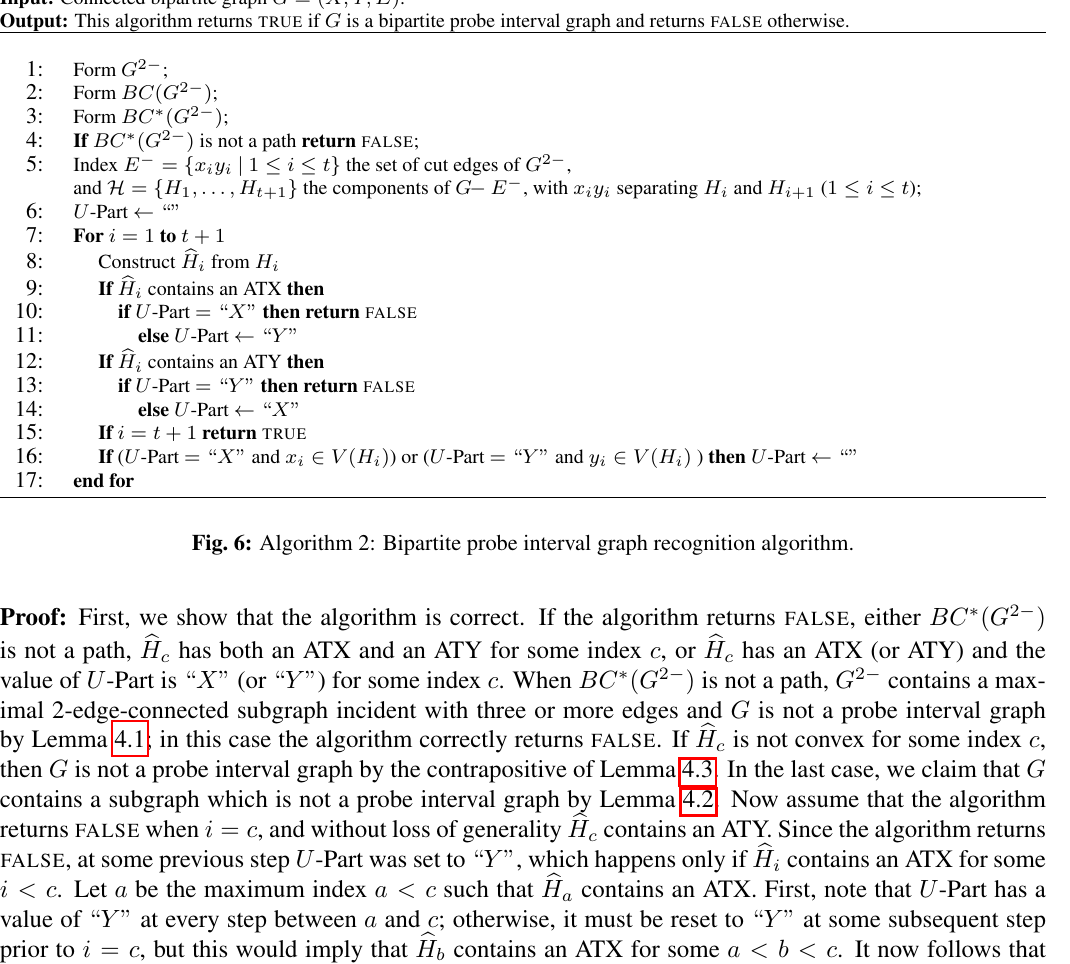
Algorithm 2 G is a bipartite probe interval graph.